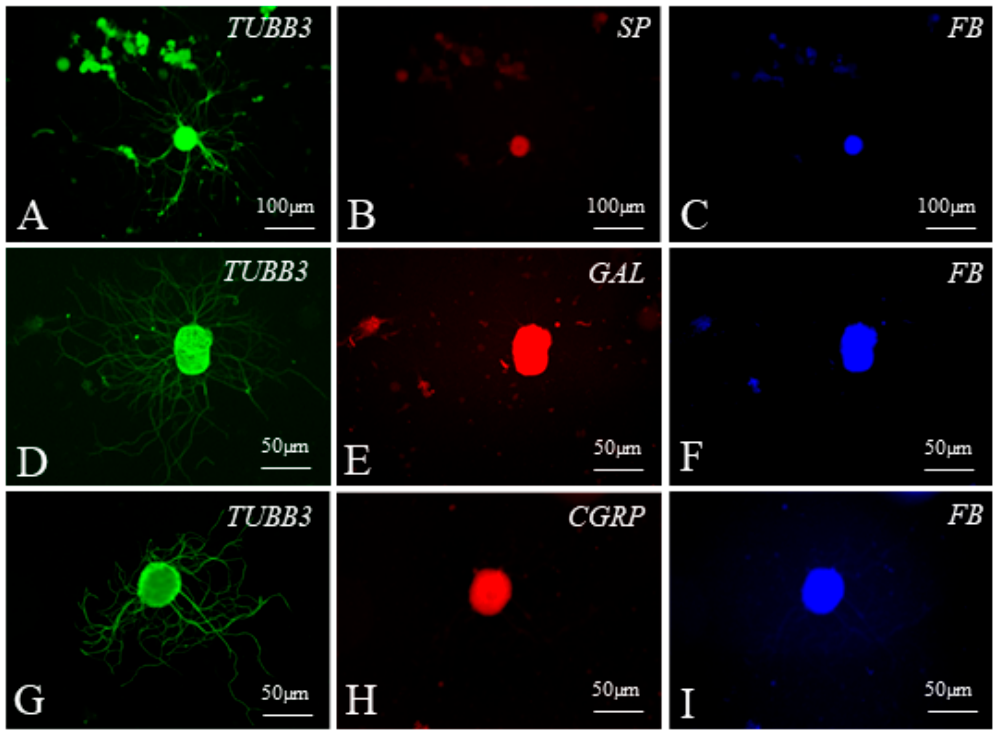
Figure 8. Examples of dorsal root ganglia (DRG) neurons supplying the ileocecal valve (FB-positive blue) ( C , F , I ) immunoreactive to tubulin (TUBB3 used here as a neuronal marker, green) ( A , D , G ) and substance P (SP) ( B ), galanin (GAL) ( E ), and calcitonin gene-related peptide (CGRP) ( H ) (all these substances in red) in cell cultures treated with lipopolysaccharides from Salmonella Enteritidis ( A – C ), Salmonella Typhimurium ( D – F ) and Salmonella Minnesota ( G – I ).